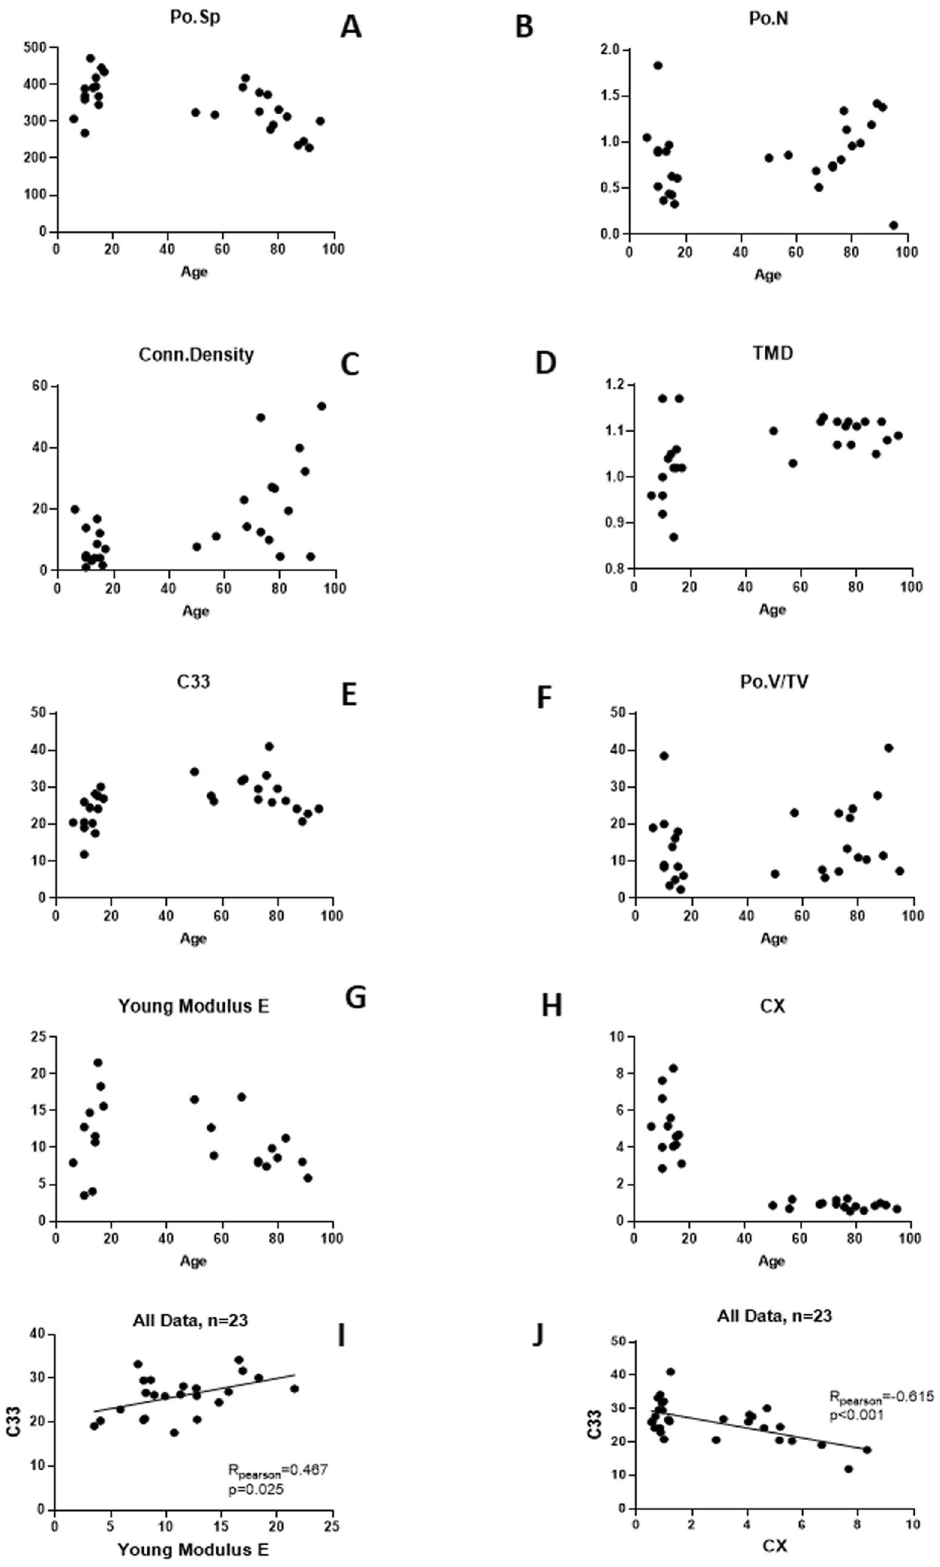
Figure 4. Graphs depending on age of ( A ) porosity separation Po.Sp (µm), ( B ) porosity number Po.N (1/mm), ( C ) connectivity density Conn.Density (1/mm 3 ), ( D ) tissue mineral density TMD (g/cm 3 ), ( E ) traction–compression stiffness coefficient C 33 (GPa), ( F ) pore volume over tissue volume Po.V/TV (%) ( G ) compression modulus E (GPa), ( H ) cross-links ratio immature over mature CX (mmol/mol collagen). Relationships for all data between parameters traction–compression stiffness coefficient C 33 versus, ( I ) compression modulus E (GPa), and ( J ) cross-links ratio immature over mature CX (mmol/ mol